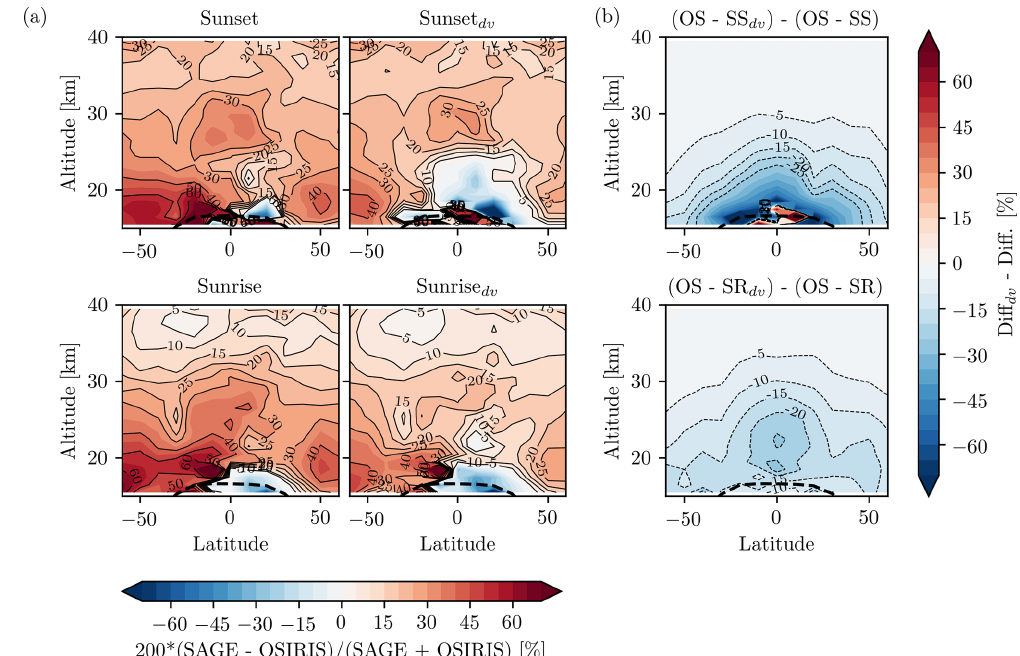
Figure 9. (a) Zonal mean percent differences of SAGE III/ISS sunset and sunrise NO 2 and OSIRIS NO 2 coincident measurements for the SAGE v5.1 and diurnally varying (dv) retrievals. The contour spacing is 5%. The bold dashed line is the mean tropopause location. (b) Difference between the columns in (a)